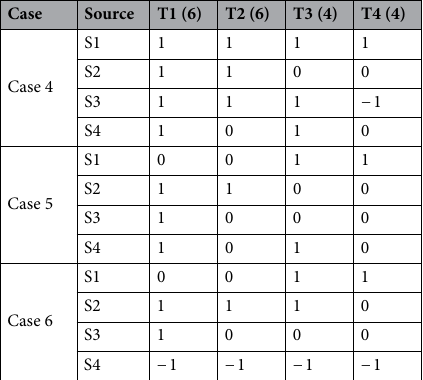
Table 5. Input data for different scenarios of evolution of CO 2 point sources (1 indicates open, 0 indicates closed, and − 1 indicates unknown status).